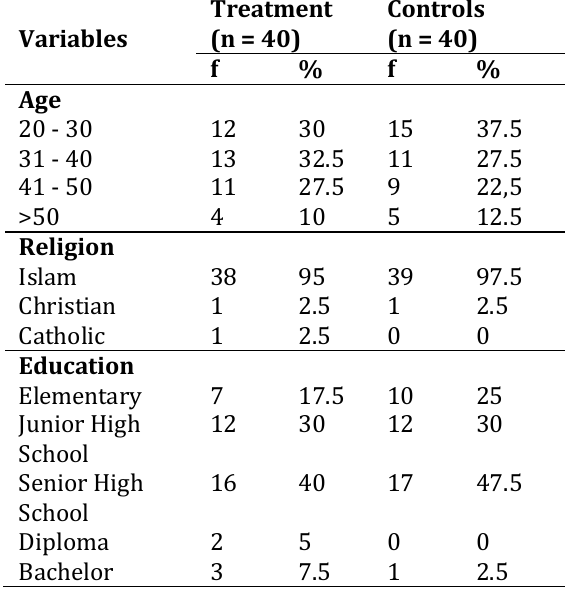
Table 1. Demographic Characteristics